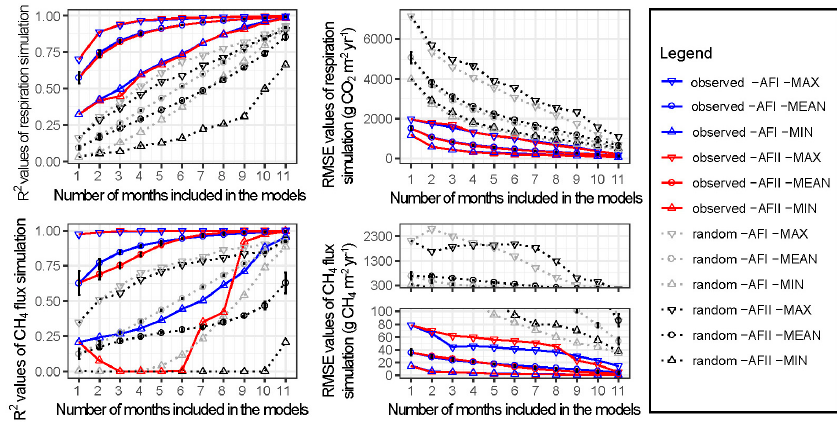
Figure 4. Maximum, minimum, and mean ± standard error of the R 2 and RMSE values between AFobs and AFsim for simulations with different sampling frequencies. Results are based on 4094 linear regression equations for the arithmetic average (AFI) and weighted average (AFII) methods. The blue and red lines indicate the result of observed data of verification group (not used in equation development). The grey and black lines indicate the result of random data (for more information, see Section 4.3). The sample size is 106 for the soil/ecosystem respiration and 46 for the CH 4 of both the observed data and the random data. All mean R 2 and RMSE values are shown with the standard error, yet some are too small to be visible. Some symbols are overlapping, such that some symbols are invisible.